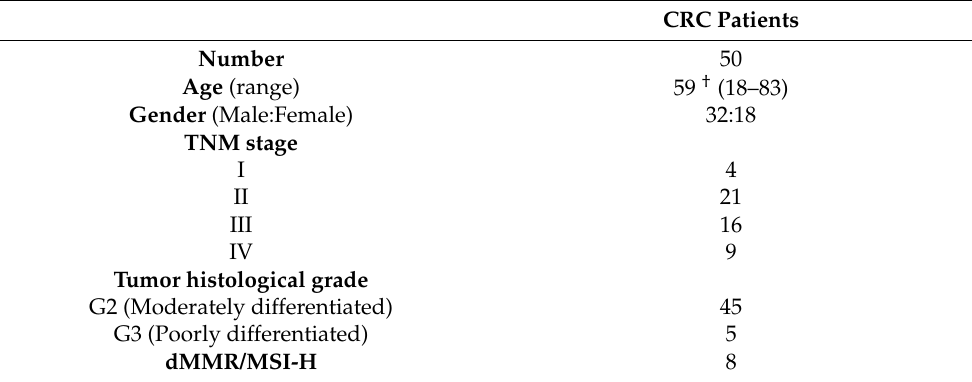
Table 1. Clinical and pathological features of study